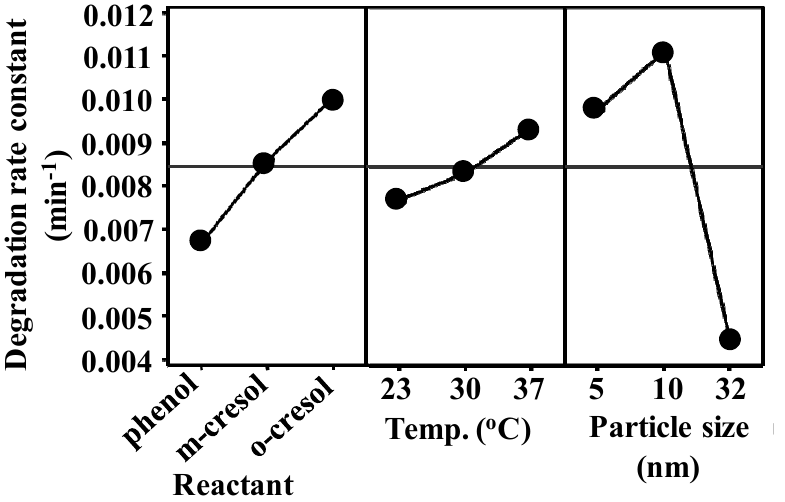
Figure 4. Main effect plots for the experimental